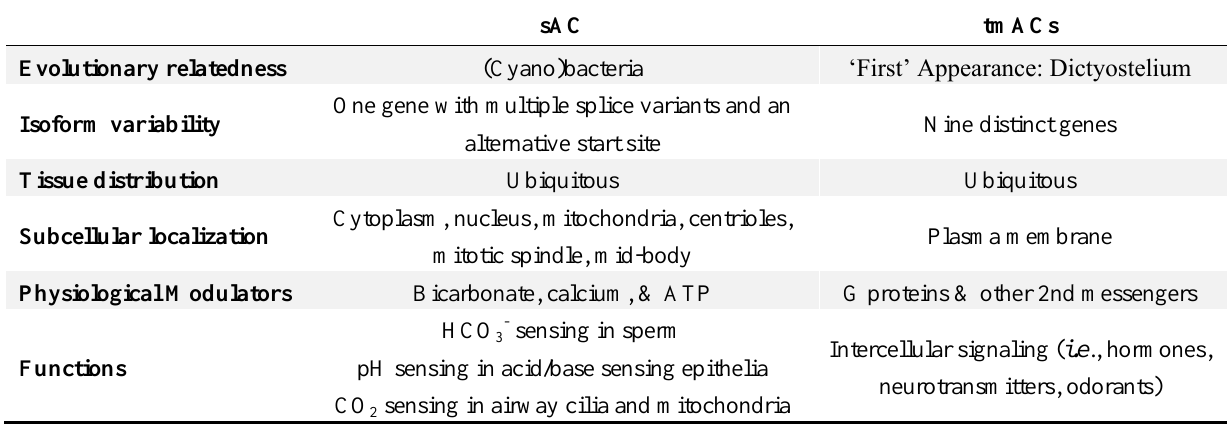
Table 1. The two distinct classes of mammalian adenylyl cyclase. sAC